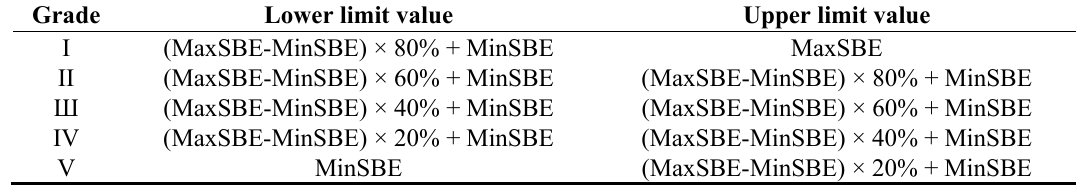
Table 3. Calculation for lower limit value and upper limit value for each grade (based on Zhang [12]). Grade Lower limit